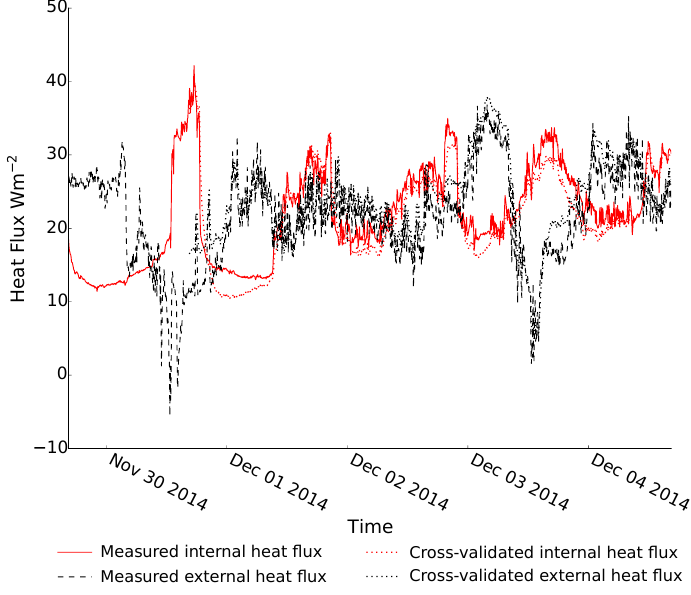
Figure 6. Measured and cross-validated (using the 2TM model) heat flux time series for the